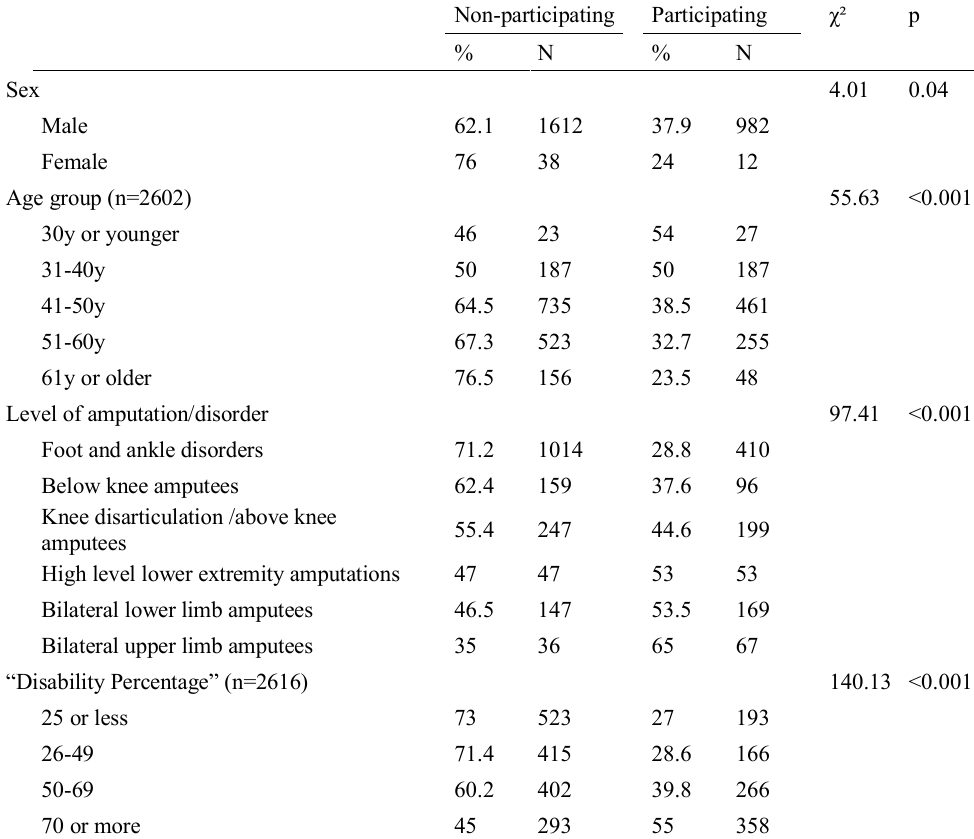
Table 1. Demographic and clinical characteristics of the participants.